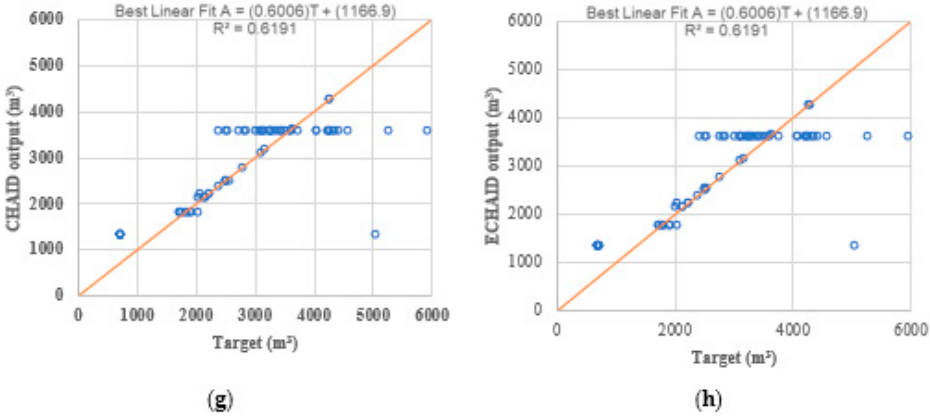
Figure 3. Regression between predicted and simulated natural gas consumption: ( a ) MLR model vs. ( b ) BPNN model vs. ( c ) SVM vs. ( d ) BPNN model vs. ( e ) RNFN model vs. ( f ) CART model vs. ( g ) CHAID vs. ( h ) ECHAID model.